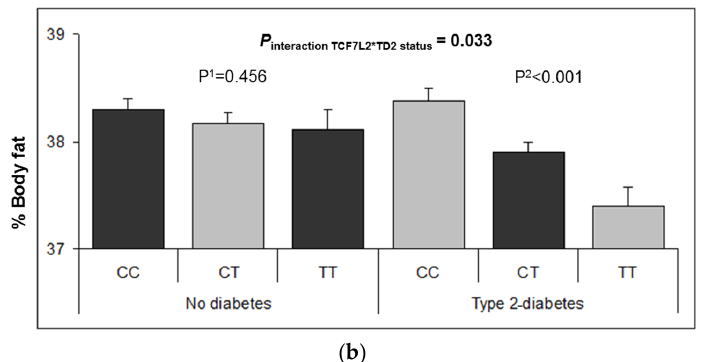
Figure 1. Adjusted means of BMI ( a ) and % body fat ( b ) at baseline depending on the TCF7L2 ‐ rs7903146 polymorphism and T2D diabetes status ( n = in 7018 PREDIMED participants at baseline. Means were adjusted for age, sex, center, total energy intake, physical activity, smoking, drinking, adherence to the Mediterranean diet, dyslipidemia, and hypertension. The p ‐ values for the interaction terms were obtained in the corresponding multivariable adjusted models. p 1 and p 2 values were obtained for the multivariable comparison of means between depending on the T2D strata in non ‐ diabetic ( n = 3607) subjects and T2D ( n = 3411) subjects, respectively. Error bars: SE of means. Table 3. Association between the TCF7L2-rs7903146 polymorphism and obesity depending on T2D status. Stratified logistic regression analysis.